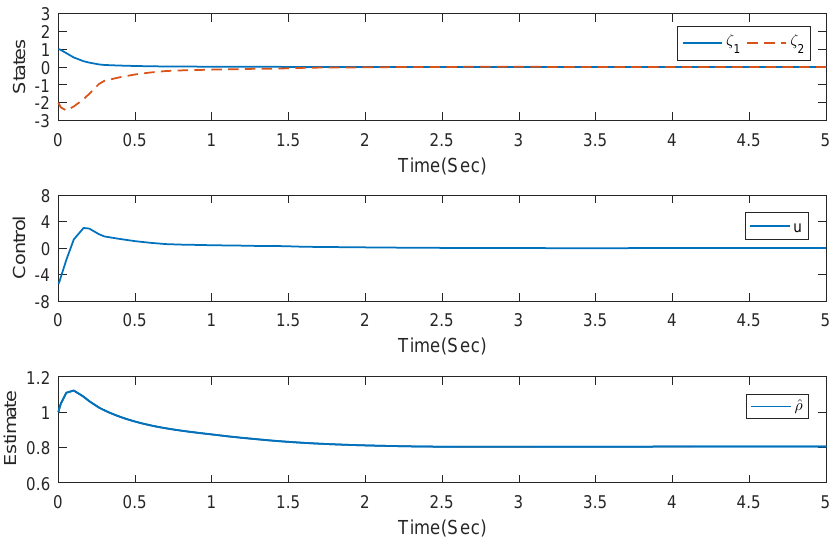
Figure 1. The response of the closed-loop system